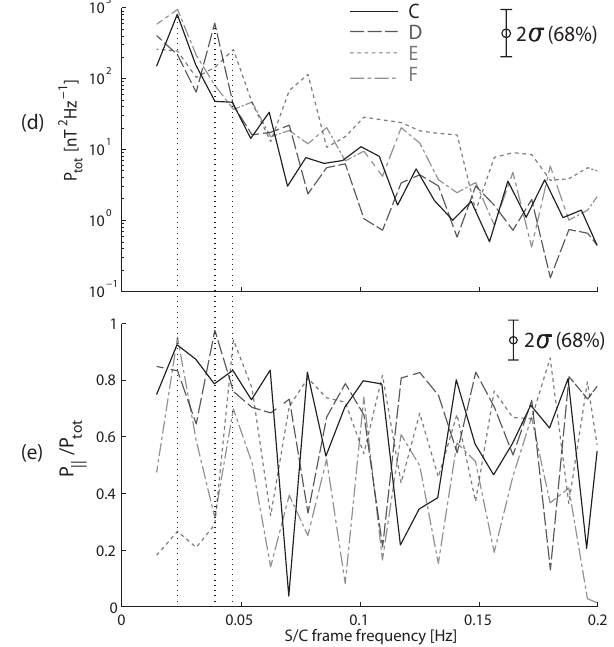
Figure 3. (d) Total power spectral density and (e) ratio between compressional and total poser spectral density for the four time in- tervals (C, D, E and F) marked in Fig. 3a, b, and c, based on Giotto data. Only the relevant frequency range is